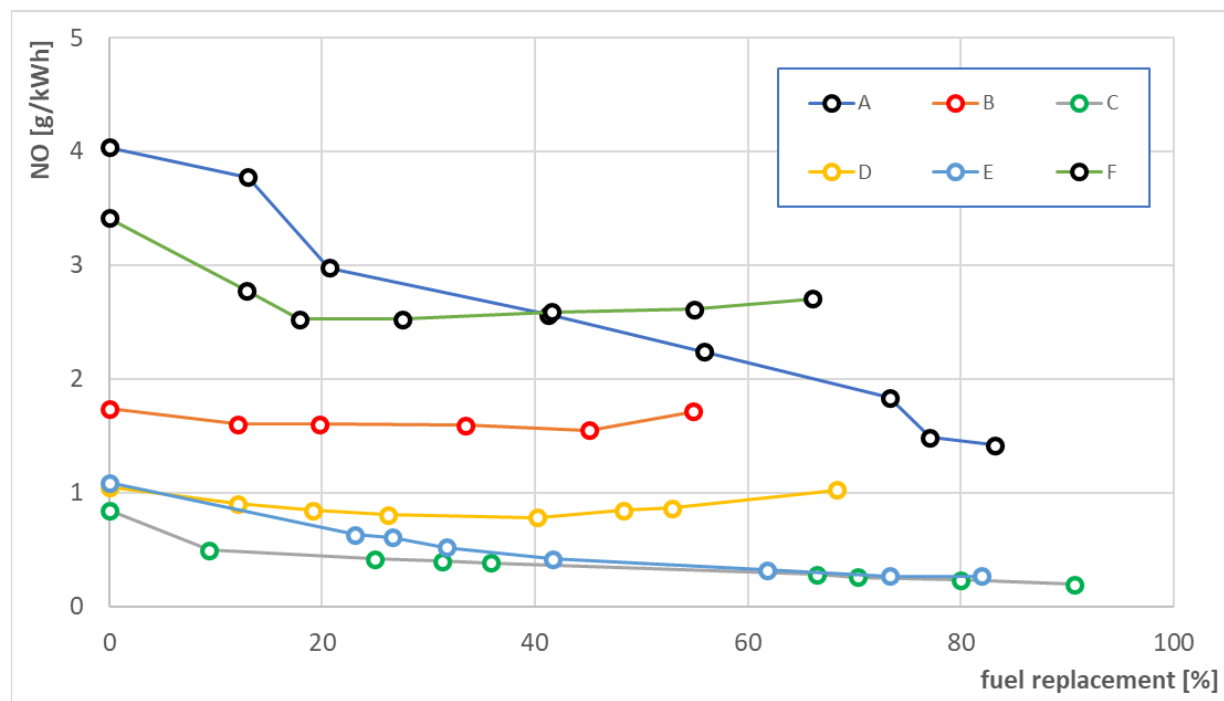
Figure 5. Curves from A to F showing engine’s emission of NO (nitric oxide), for individual engine operating points, where the rotation speed, power, and torque were constant, as a replacement function of diesel fuel replaced by CNG.